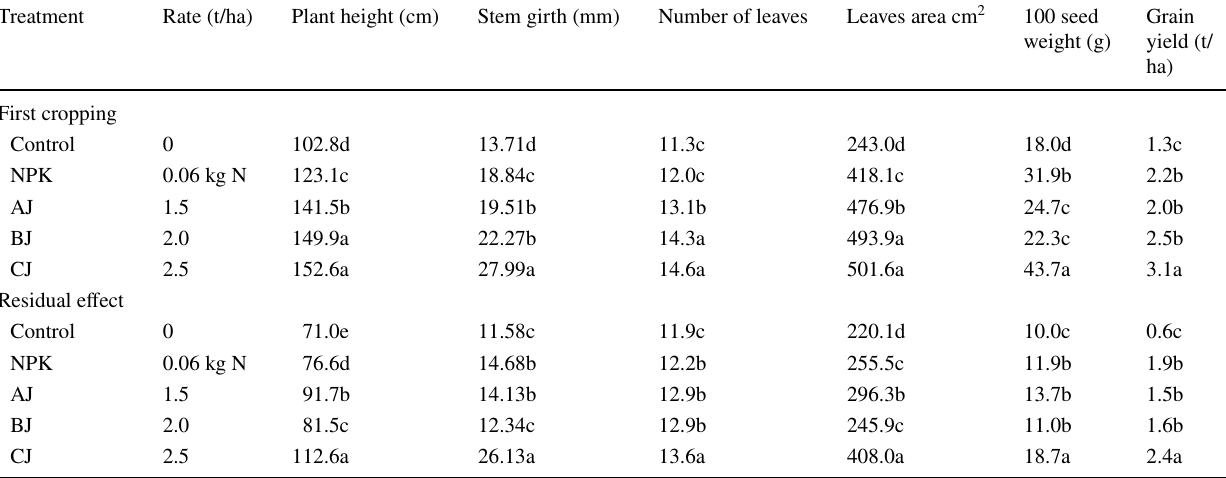
Table 3 Effects of fertilizer types on growth and yield of maize at the first and second field cropping